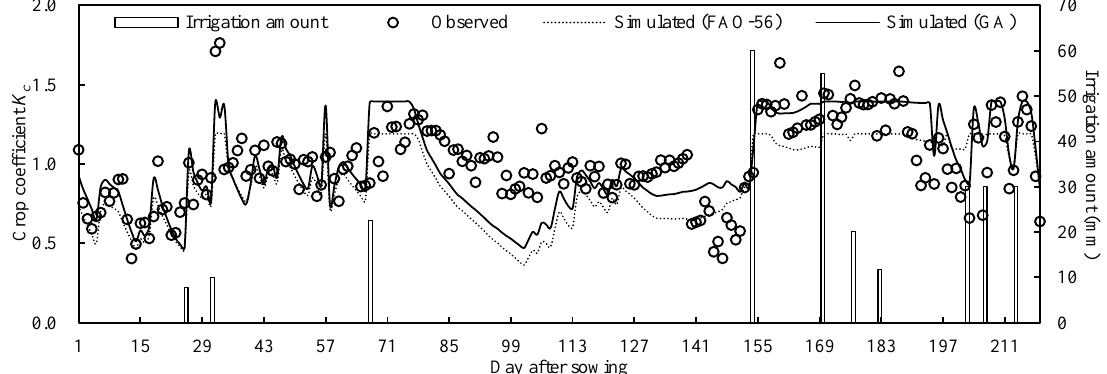
Figure 7. Observed and simulated daily winter wheat crop coefficient ( K c ) during the whole growth period in T5 using the crop coefficients recommended by the FAO-56 and optimized by the genetic algorithm (GA).